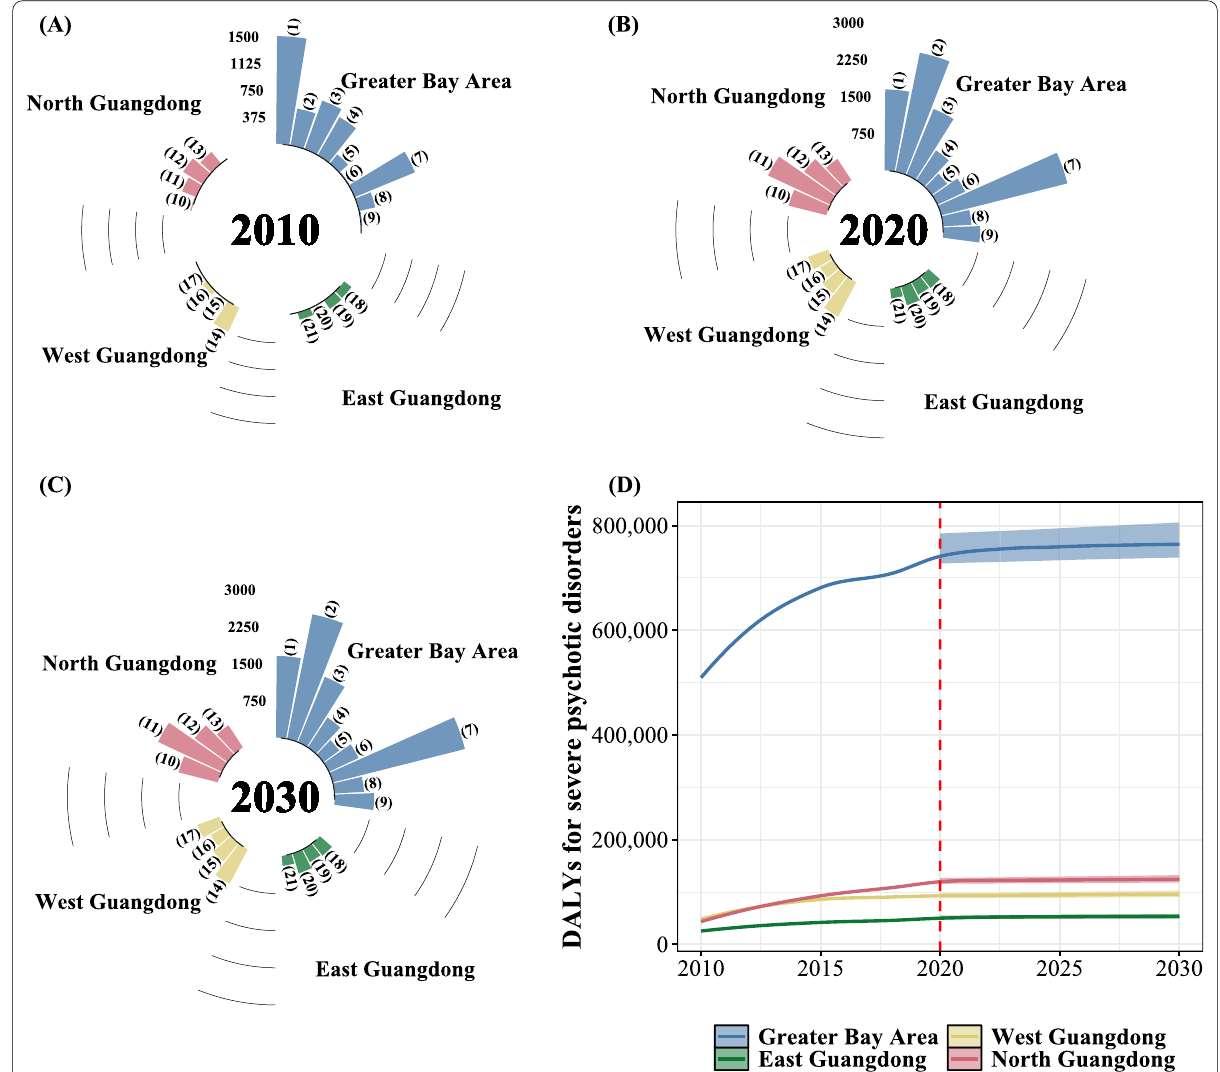
Fig. 2 Temporal trends ( a–c ) for age-standardized DALY a rates and forecasts ( d ) for absolute DALYs ascribed to severe mental disorders in Guangdong, China, during 2010–2030, by economic region. a DALY: disability-adjusted life-years, for which comorbidity-adjusted estimates were reported. Age-standardized rates were calculated based on the Chinese population reported by the GBD 2019 [31]. Notes: In ( a–c ), region-specific patterns of age-standardized DALYs ascribed to severe mental disorders during 2010–2030 were depicted. The Greater Bay Area refers to Guangzhou(1), Foshan(2), Zhaoqing(5), Shenzhen(3), Dongguan(4), Huizhou(6), Zhuhai(7), Zhongshan(8), Jiangmen(9). The North Guangdong region refers to Shaoguan(10), Qingyuan(11), Meizhou(12), and Heyuan(13). The West Guangdong region refers to Zhanjiang(14), Yangjiang(15), Maoming(16) and Yunfu(17). Finally, the East Guangdong region refers to Chaozhou(18), Shantou(19), Jieyang(20), and Shanwei(21). In panel (D), temporal trends between 2010 and 2030 were shown, for four economic regions of Guangdong. Uncertainty intervals of forecasts for DALYs were presented in shaded